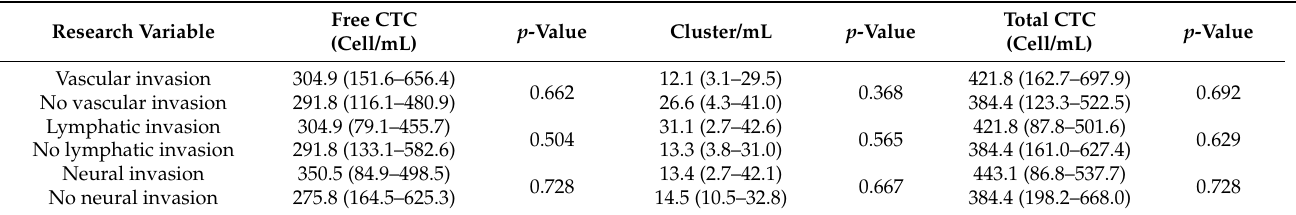
Table 6. Correlation of CTC and CTC clusters with microscopic invasion (CVC measurements).